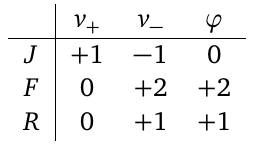
Table 2: Weights of monopole operators in the SQED [ 1 ] A